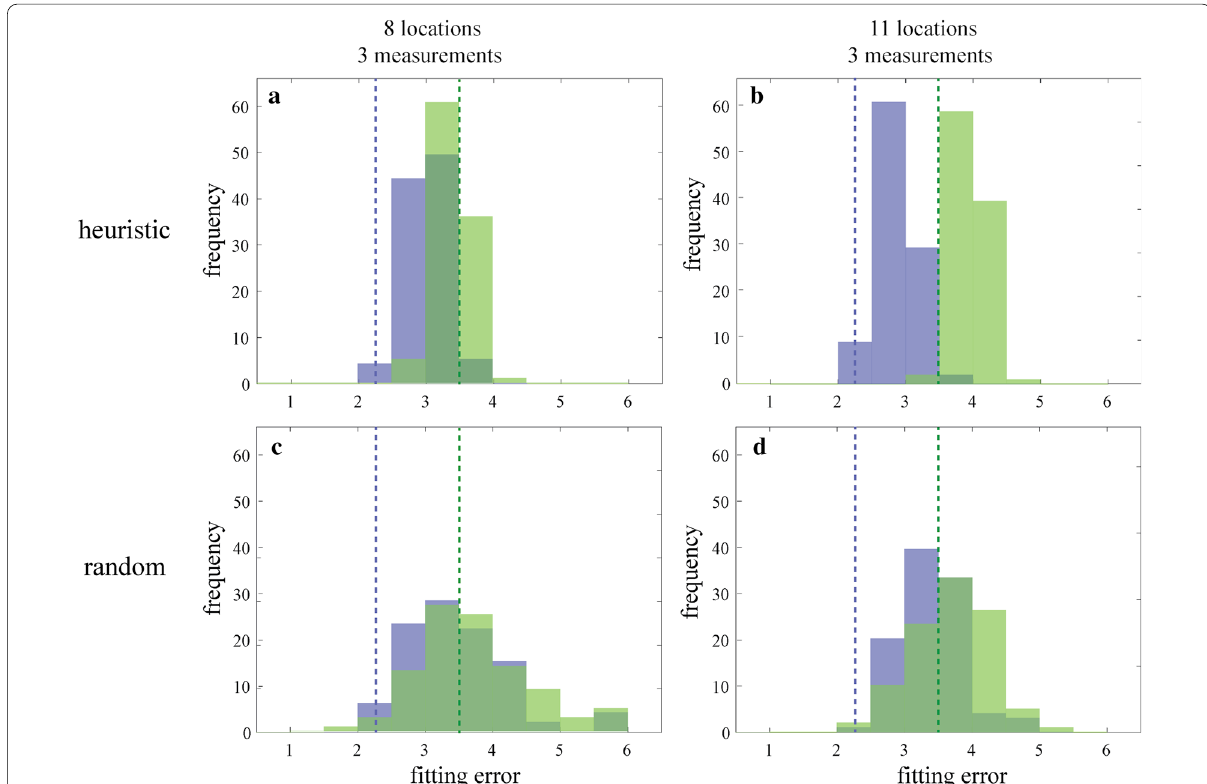
Fig. 6 Generated distributions of final fitting error using heuristic (top row) versus random (bottom row) sampling strategies. Each distribution is the result of 100 iterations, with ( a ) 3 measurements at 8 evenly spaced locations; ( b ) 3 measurements at 11 evenly spaced locations; ( c ) 3 measurements at 8 randomly selected locations; ( d ) 3 measurements at 11 randomly selected locations. Iterations were run on datasets corresponding to the given hypothesis (blue) and the alternative-unknown hypothesis (green), and for each of the resulting generated datasets the final hypothesis fitting error was computed. The blue and green dashed vertical lines show the representative fitting error for the null and alternative dataset respectively, i.e., the fitting error if all possible (220) measurements in that dataset were collected